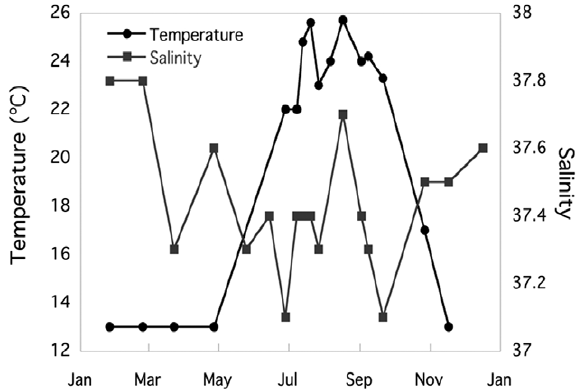
Fig. 1. – Temperature and salinity in the water of Sant Andreu de Llavaneres Beach in 2010.